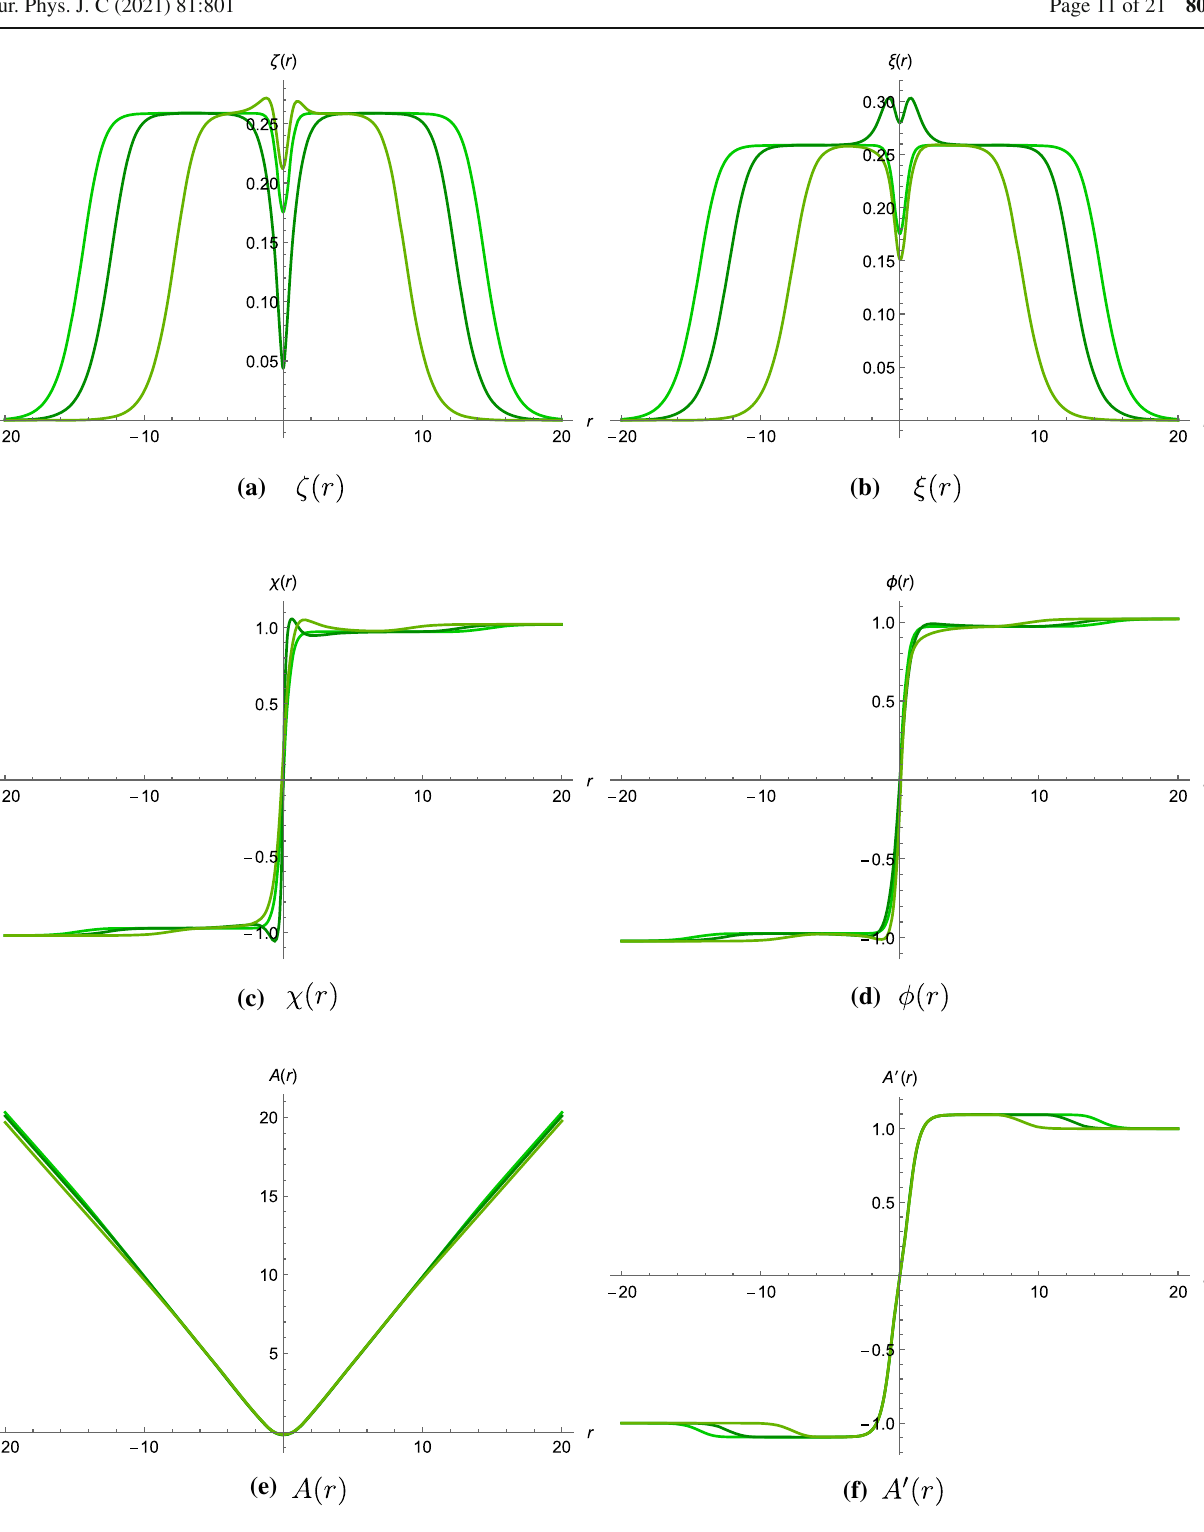
Fig. 6 Profiles of scalar fields (ζ,ξ,χ,φ) and the warped factor A for examples of G 2 / G 2 Janus solutions as functions of the radial coordinate